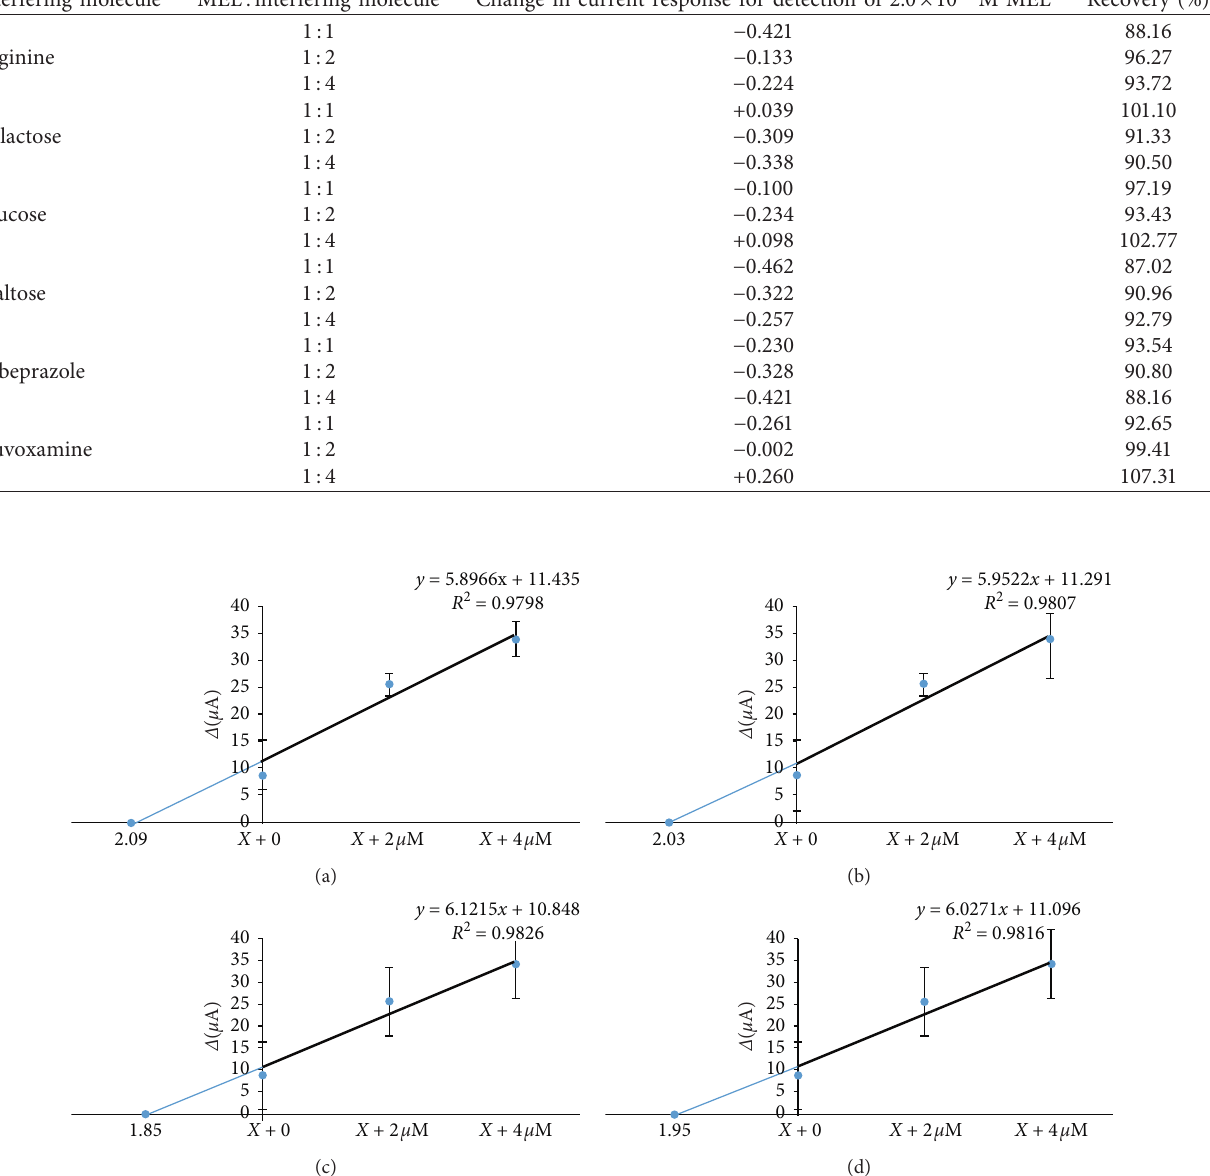
Table 4: Selectivity of sensor MEL (2.0 × 10 − 6 M) in presence of interfering molecules. Interfering molecule MEL:interfering molecule